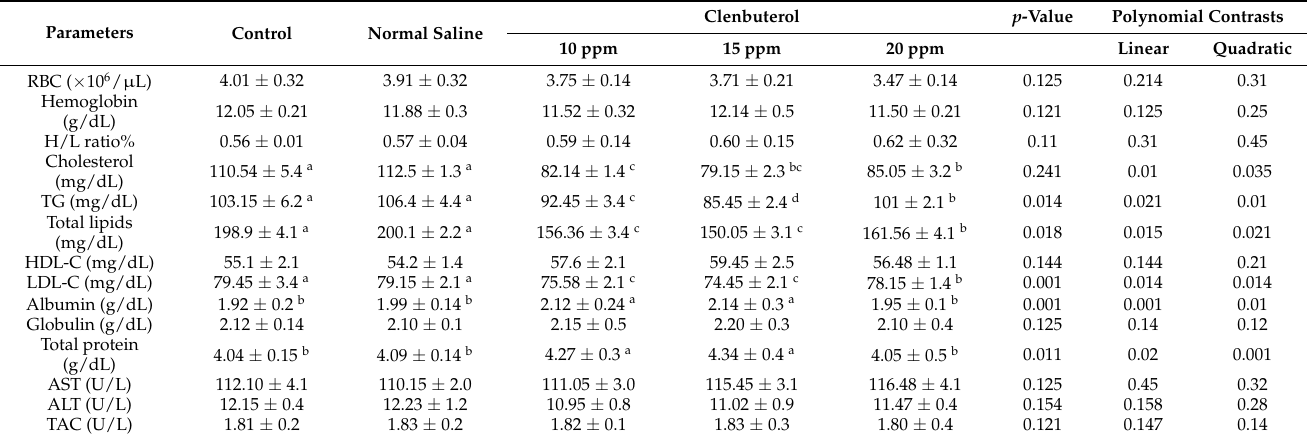
Table 4. Effect of in ovo feeding of clenbuterol on hematological and biochemical markers pattern of chicken. Parameters Control